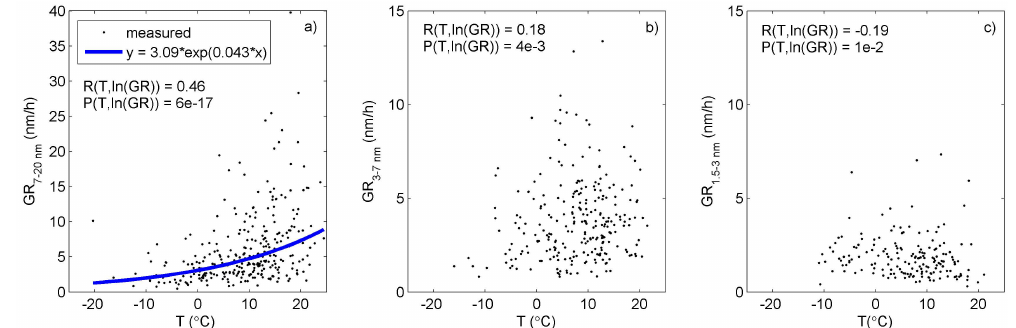
Fig. 7. Growth rate (GR) of particles in the size ranges (a) 7–20nm, (b) 3–7nm and (c) 1.5–3nm as a function of temperature ( T ) and the correlation coefficient ( R ) and p-value between temperature and natural logarithm of GR. For size range 7–20nm also shown is the fitted line GR= a 1 · exp( b 1 · T ).